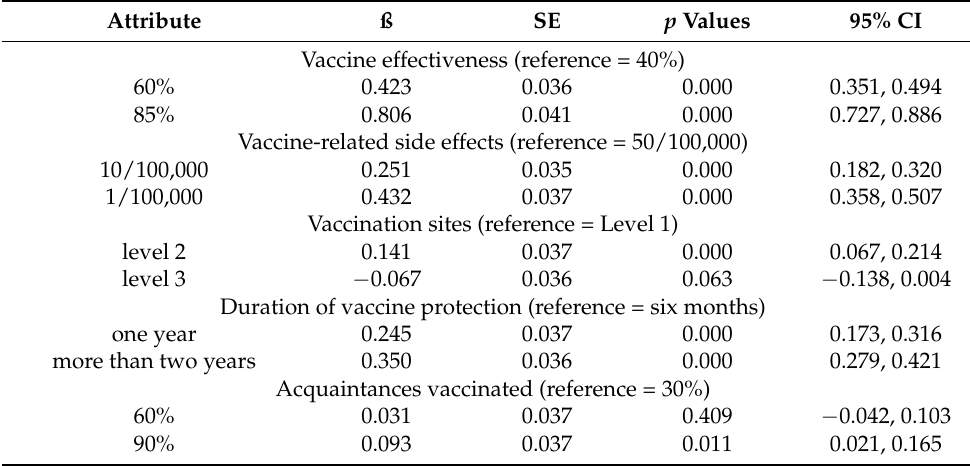
Table 4. Conditional logit model of respondent